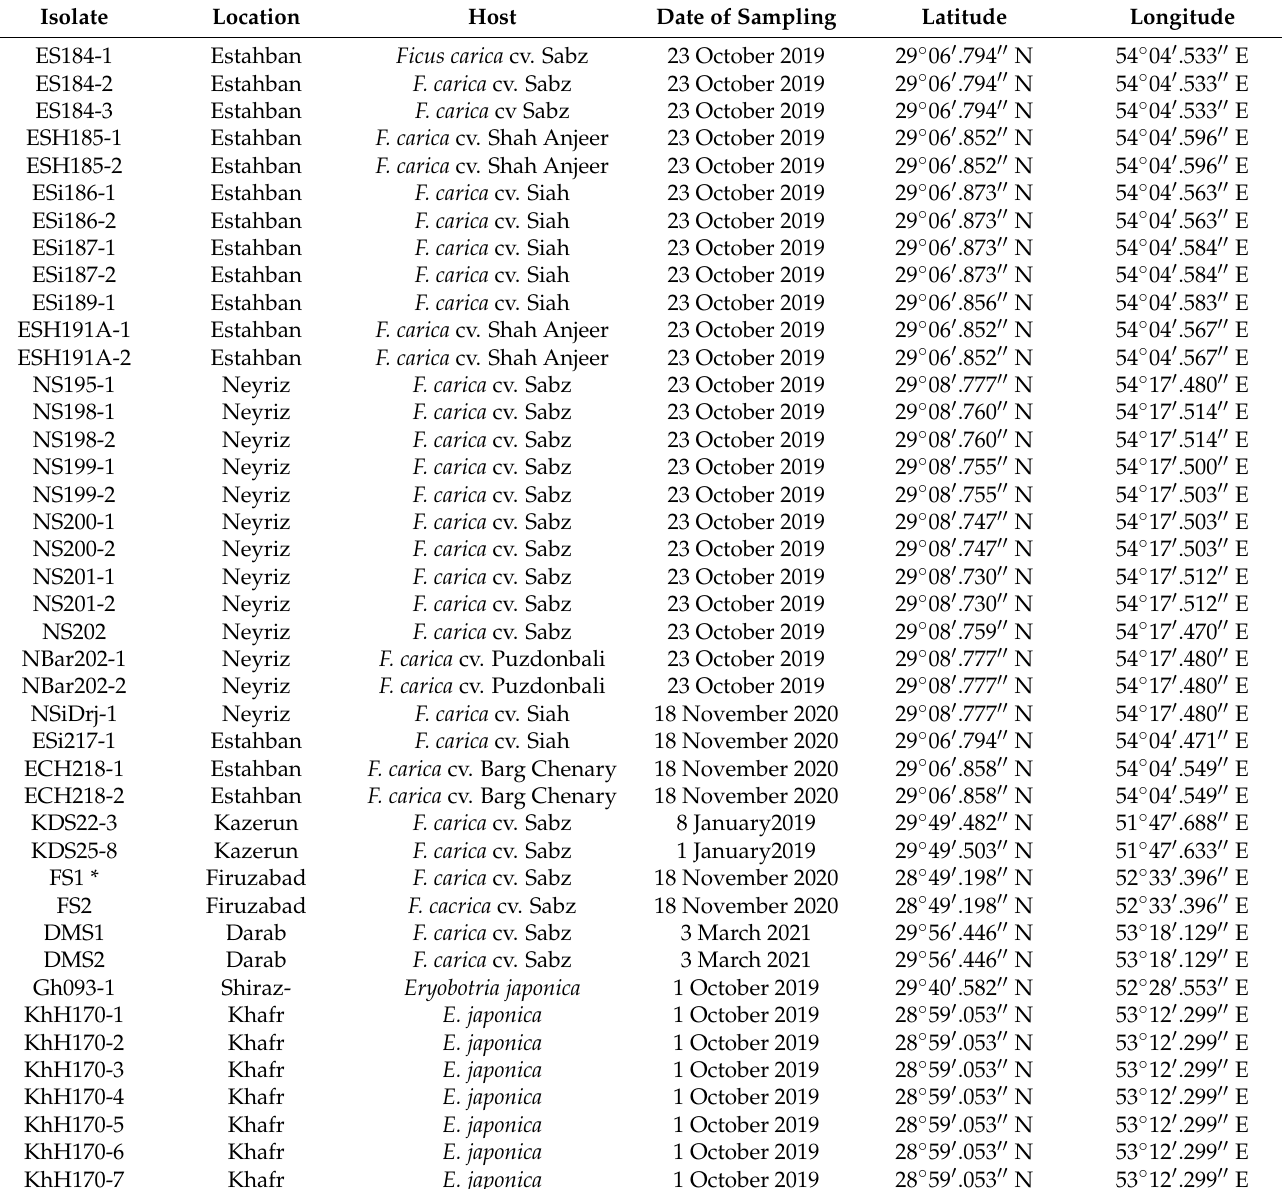
Table 2. List of Stilbocrea banihashemiana sp. nov. isolates recovered from infected fig ( Ficus carica ) and loquat ( Eriobotrya japonica ) trees in Fars Province of